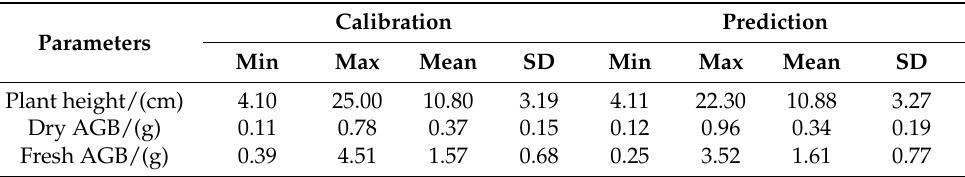
Table 2. Statistics of ground truth data for T. sinensis seedling plant height and dry and fresh aboveground biomass